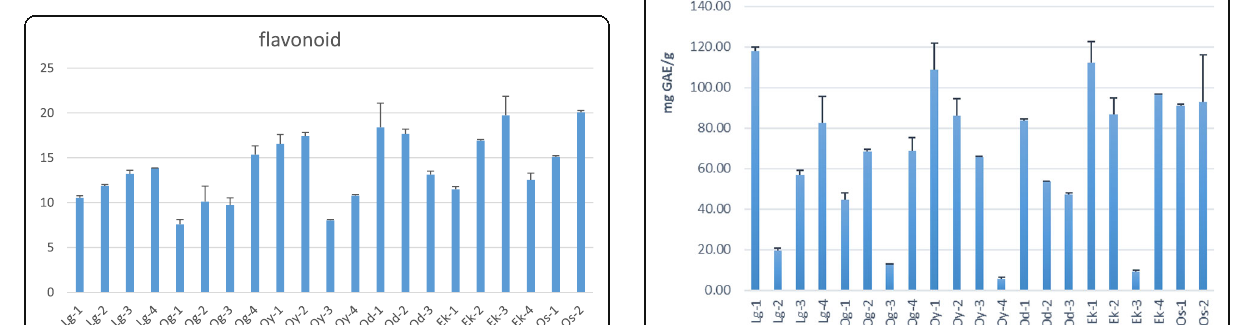
Fig. 1 Flavonoid content of Moringa oleifera leaf from the 21 locations. The results are mean of triplicates with the error bars (standard deviation). The chart shows significant between- and within-group differences